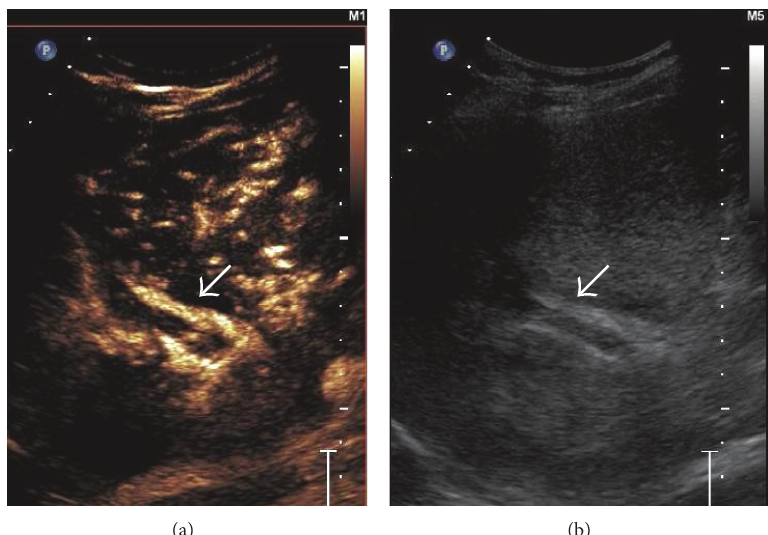
Figure 34: Side-by-side contrast-enhanced US (a) and gray-scale image (b) demonstrating absence of enhancement of the portal vein thrombus in the arterial phase (arrow in (a)) signifying benign nature of the thrombus.